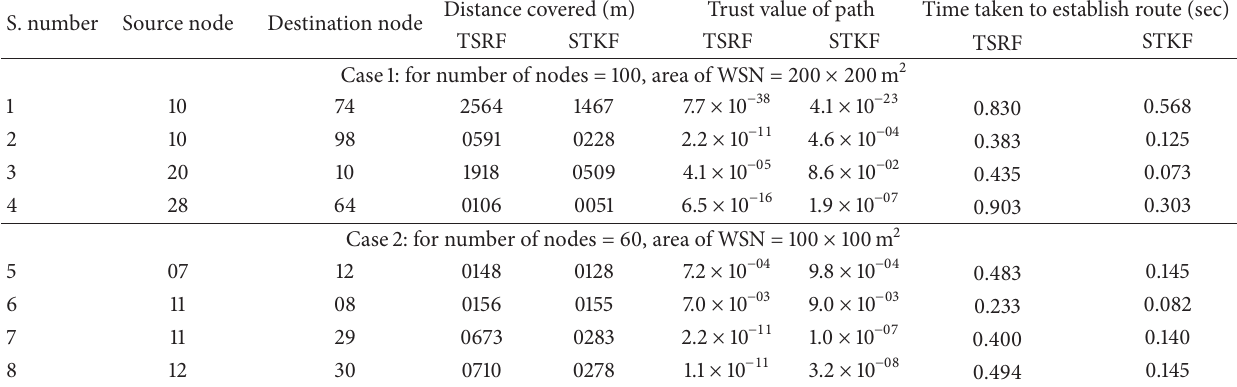
Table 2: Implementation results for conventional TSRF [4] and proposed STKF.